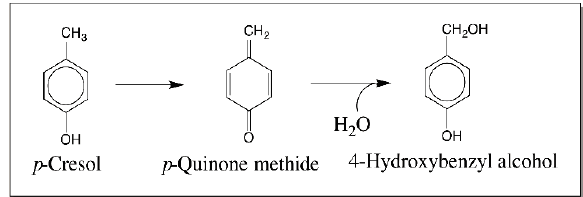
Figure 6. Rapid reaction of p -quinone methide. The simplest p -quinone methide arises from the two-electron oxidation of p -cresol. It is extremely unstable and reacts instantaneously with water forming the Michael-1,6-adduct, 4-hydroxybenzyl alcohol.